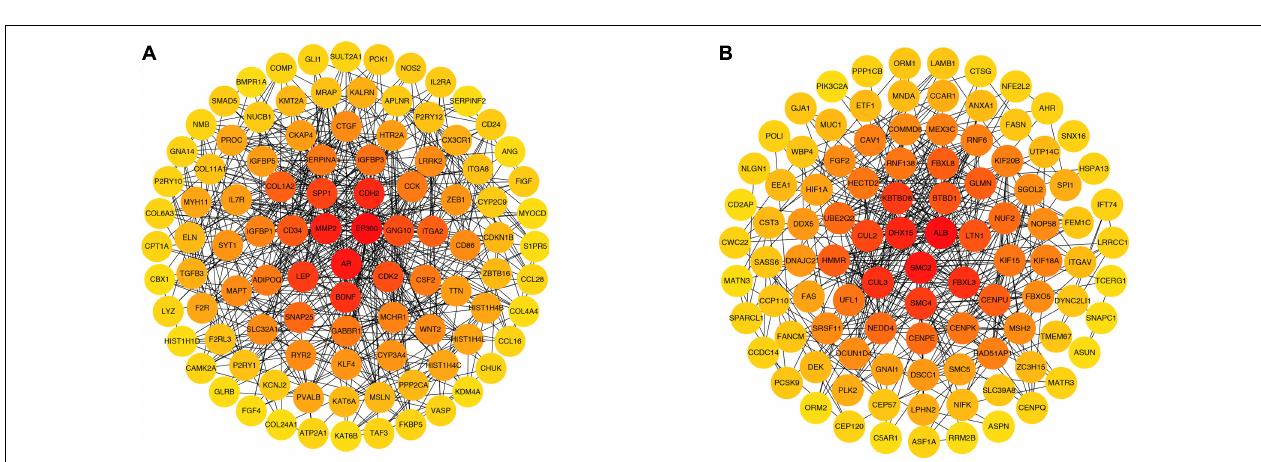
FIGURE 5 | Gene Ontology terms in (A) biological process, (B) cellular component, (C) molecular function and, (D) KEGG pathway of genes in the brown module.